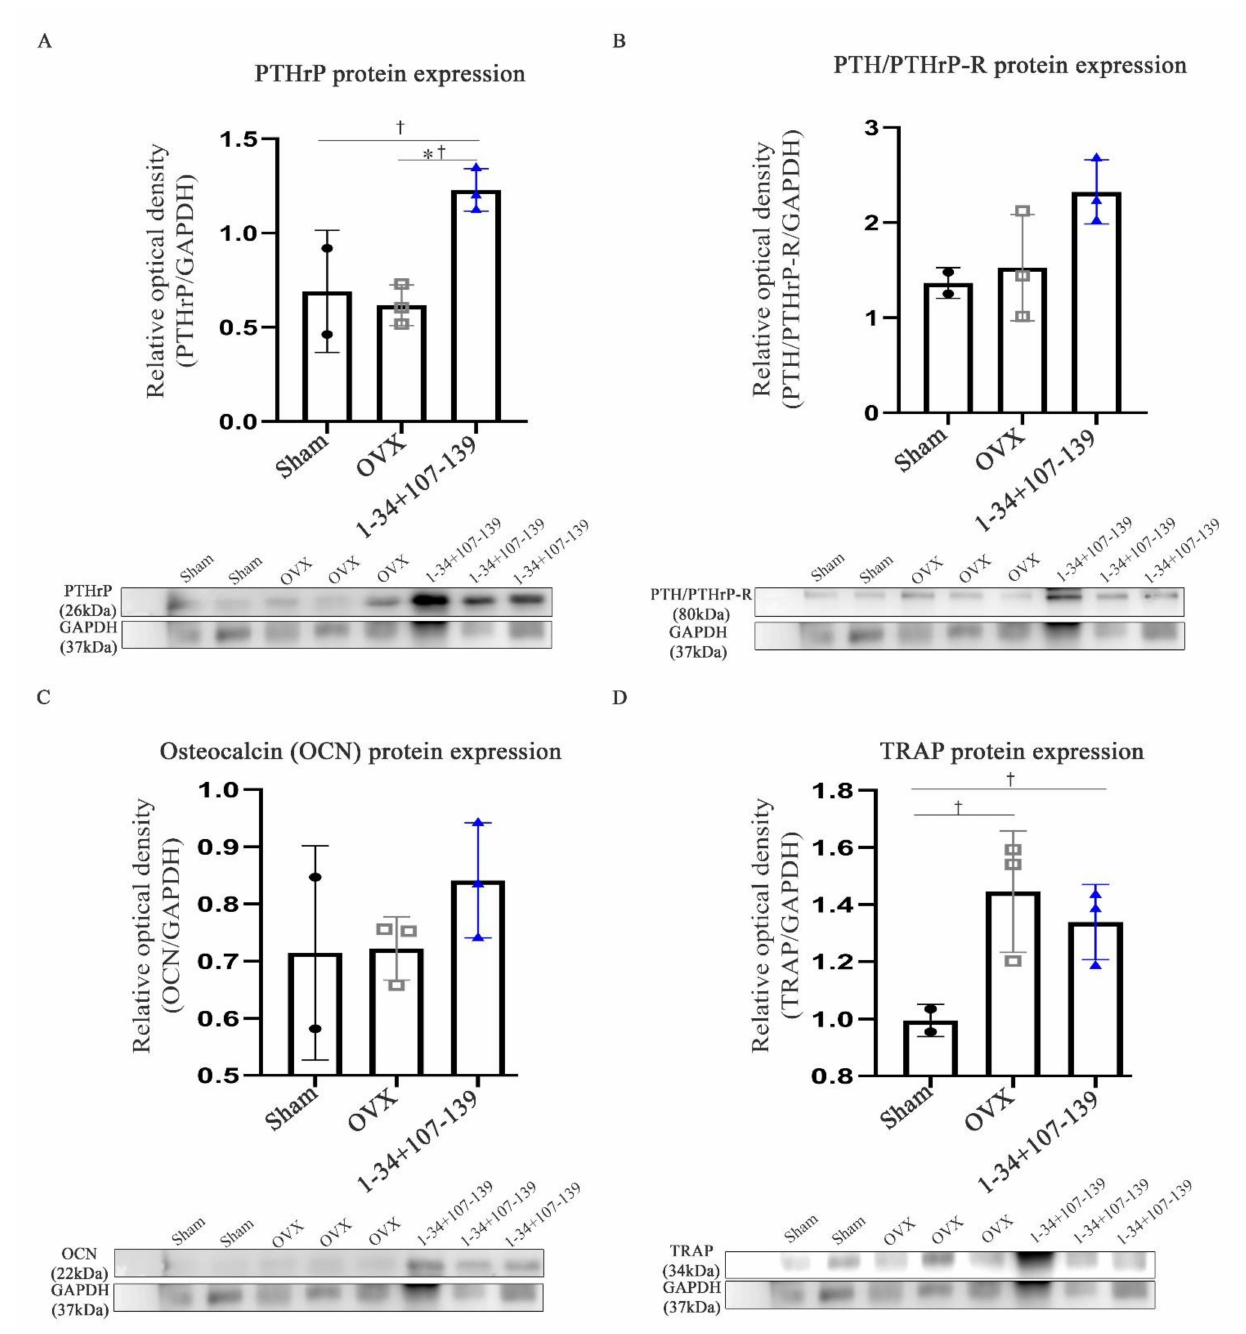
Figure 5. Protein expression of PTHrP, PTH/PTHrP-R, and bone formation and resorption markers in the femur after the injection of mcPTHrP 1–34+107–139 into OVX mice (10 weeks post-OVX). ( A ) Protein expression of PTHrP. ( B ) Protein expression of PTH/PTHrP-R. ( C ) Protein expression of osteocalcin (OCN). ( D ) Protein expression of TRAP. The data are represented as the mean ± SEM. Statistical significance was assessed using the Kruskal–Wallis test with LSD (†) post hoc analysis and the Mann–Whitney (*) test: *† p < 0.05, n.s. = not